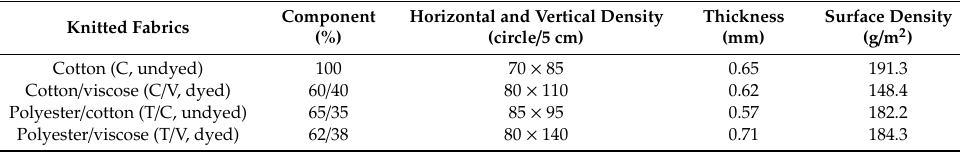
Table 1. The specification parameters of knitted